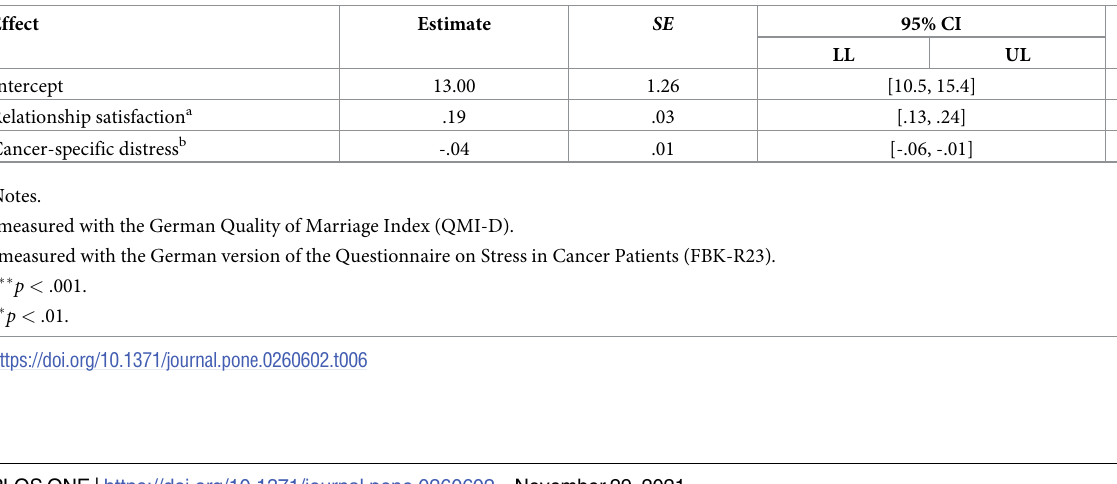
Table 6. Results of the stepwise regression analysis for partner-acceptance in women ( n = 244).